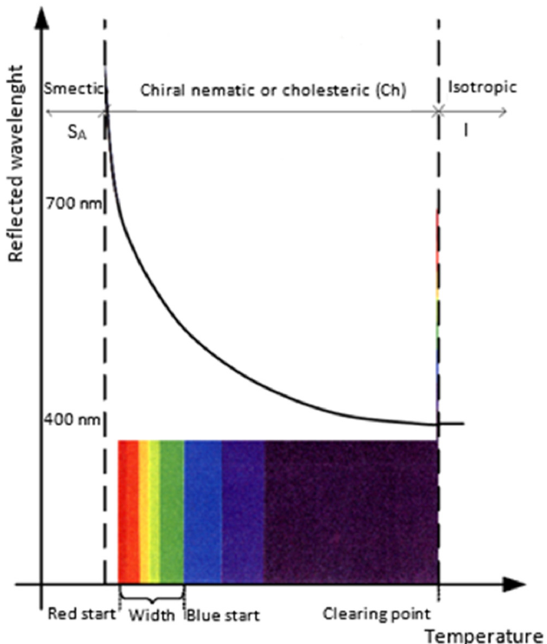
Figure 1. Typical pitch vs the temperature response of the thermochromic liquid crystal (TLC [28] The thermo-optical phenomenon occurring in the TLC can be used in two